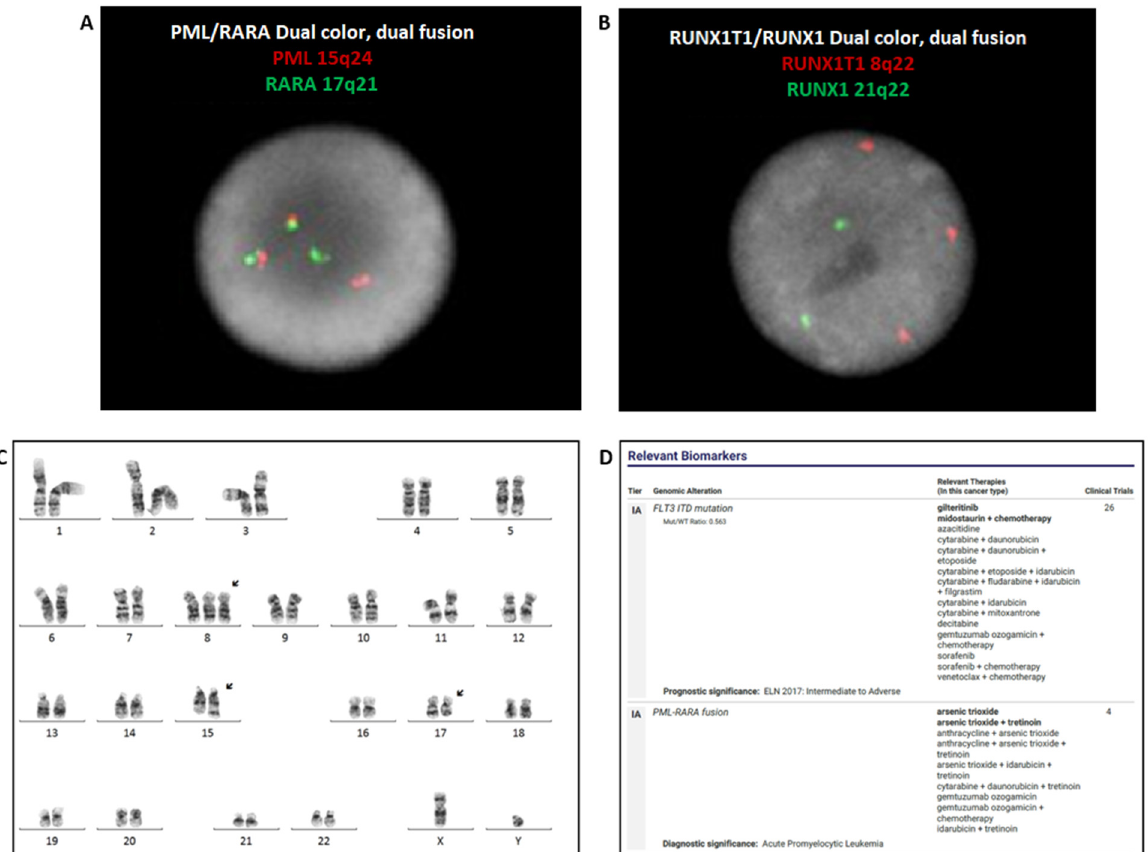
Figure 3. FISH with PML::RARA dual-color dual-fusion probes identified PML::RARA fusion ( A ). FISH with the AML panel displayed three RUNX1T1 signals (red), suggesting a gain of chromosome 8 ( B ). Chromosome analysis showed a (15;17) translocation and concurrent gain of chromosome 8, consistent with the FISH analysis. ISCN: 47,XY,+8,t(15;17)(q21;q21) ( C ). NGS detected PML::RARA fusion and FLT3 -ITD mutation (D).